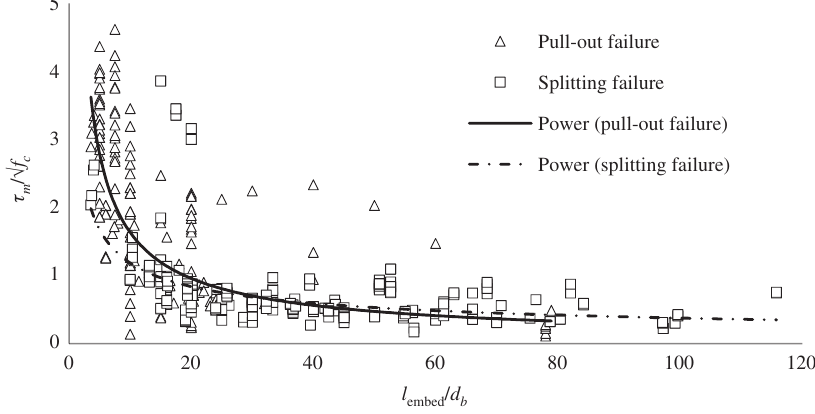
Figure 8: Variation of normalised average bond strength with normalised embedment length for pull-out and splitting failures.